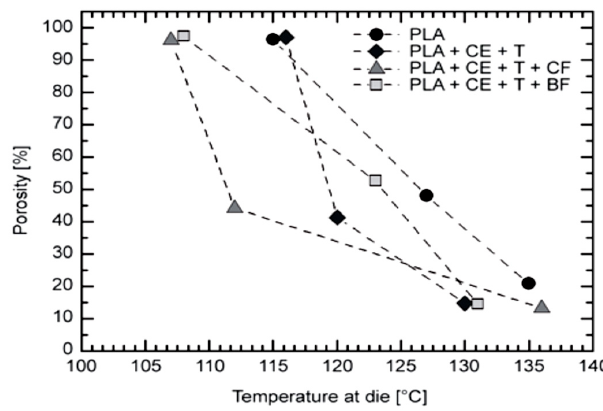
Figure 29. Effect of formulation and mixer and die temperatures on the porosity of PLA foams extruded at 8% of CO 2 . Reprinted from Bocz et al. [150] with the permission of Express Polymer Letters.